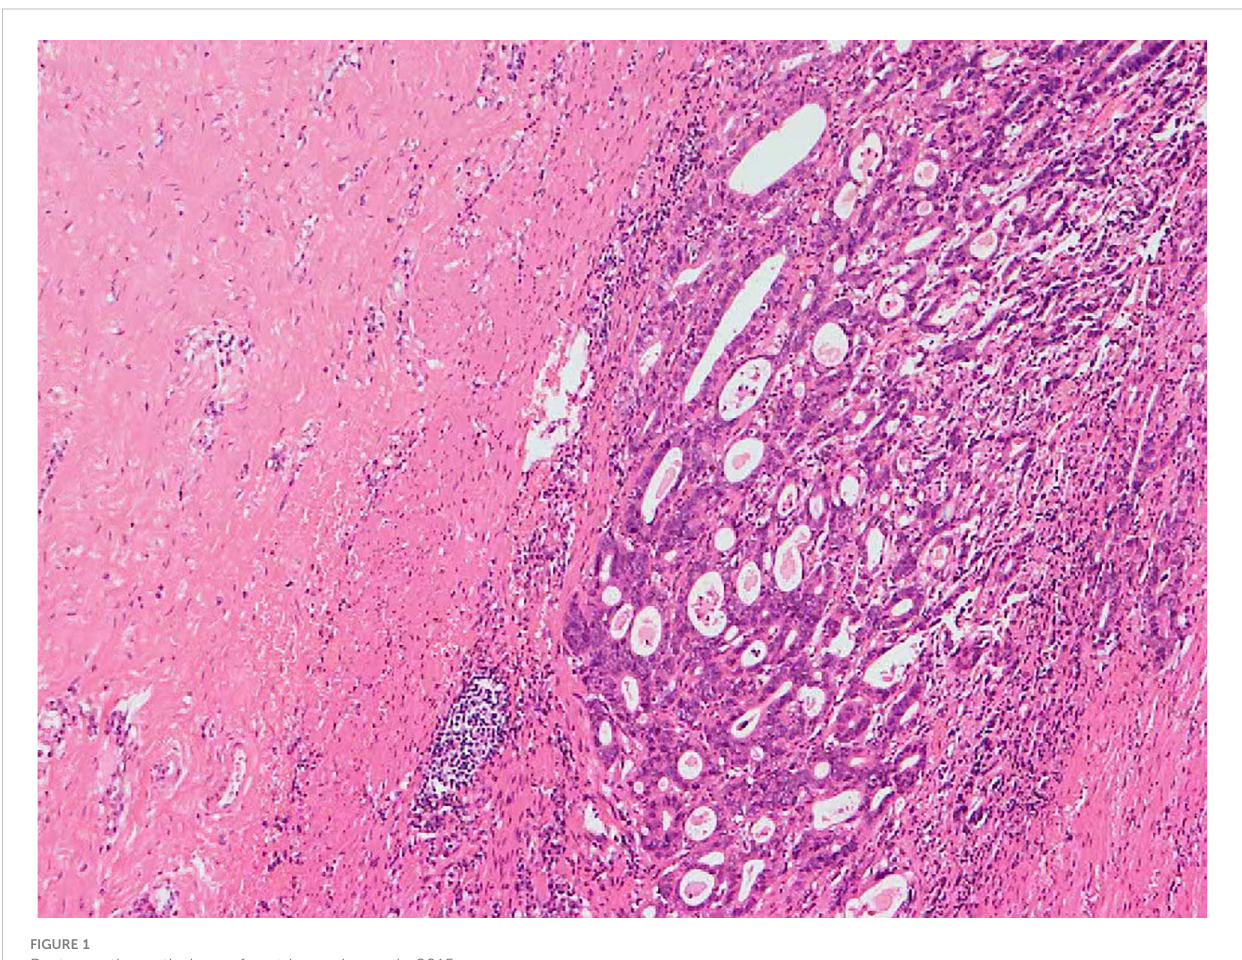
FIGURE 1 Postoperative pathology of gastric carcinoma in